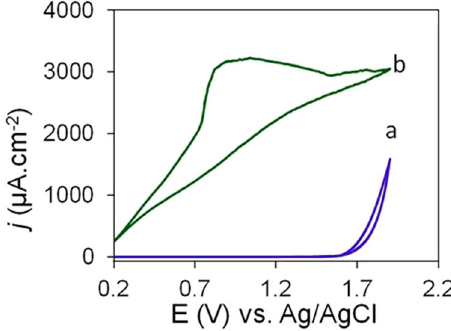
Figure 2: CVs of ( a ) MeGO/PANI in 0.02 M PBS without AA and ( b ) with 10 mM AA at the scan rate of 100 mV s − 1